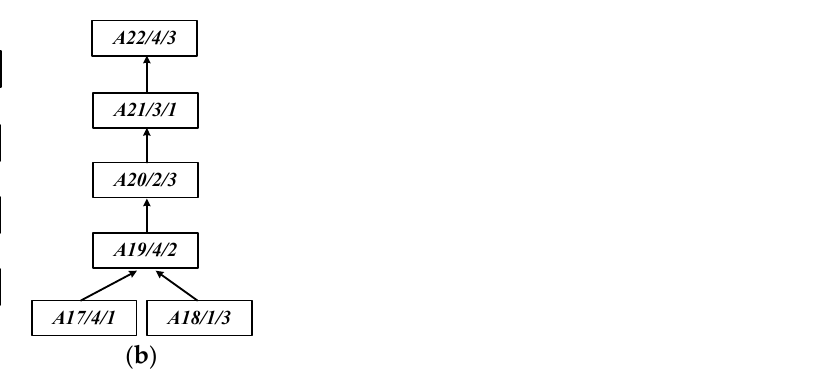
Figure 4. Each operation string after the second decomposition of operation string T A1 : ( a ) Operation string T A11 ; ( b ) Operation string T A12 .